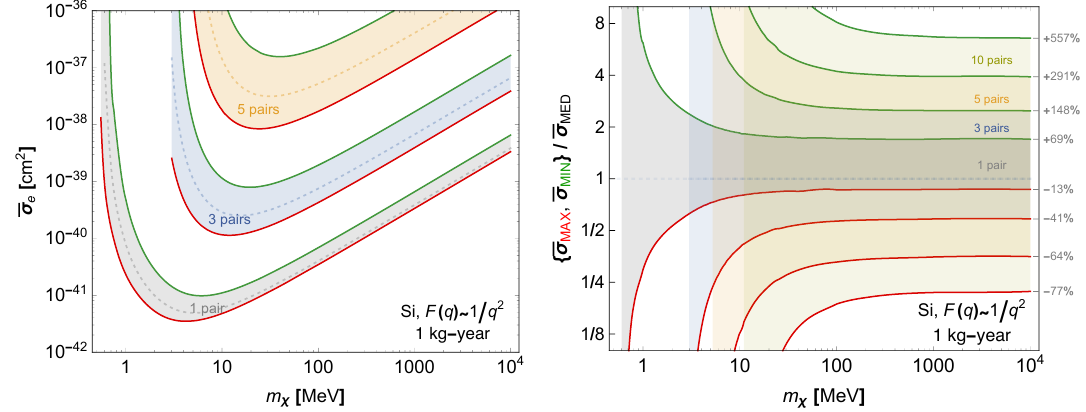
Figure 5 . The same as (cid:12)gure 3 but for F ( q )